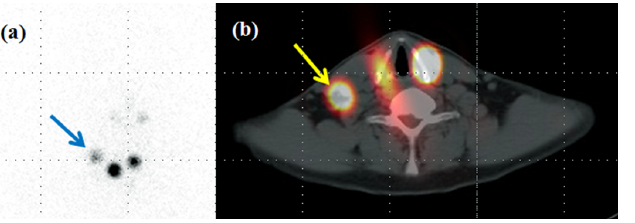
Fig 2. Postablation I-131 whole body planar scan and SPECT/CT of a patient with papillary thyroid cancer. Preablation TSH-stimulated serum thyroglobulin level was 4.7 ng/ml. A focal iodine uptake was seen in the right neck on postablation I-131 planar scintigraphy (a). The SPECT/CT image also revealed RAI uptake on a small LN in the right upper neck